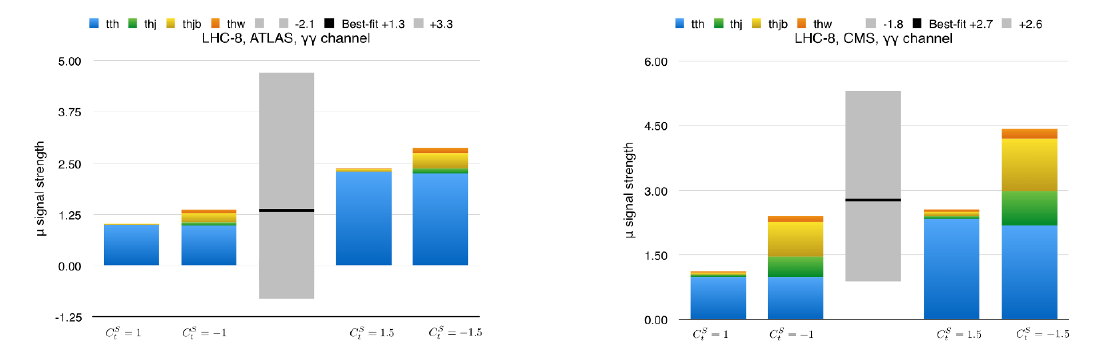
Figure 6 . Category (cid:13)(cid:13) : accumulated signal strengths (cid:22) ATLAS at LHC-8 obtained by stacking the various thX contributions on the t (cid:22) th one for C S +1 ; (cid:0) 1 ; +1 : 5 ; (cid:0) 1 : 5 from left to right. The grey columns in the center represent the current 8 TeV LHC data from table